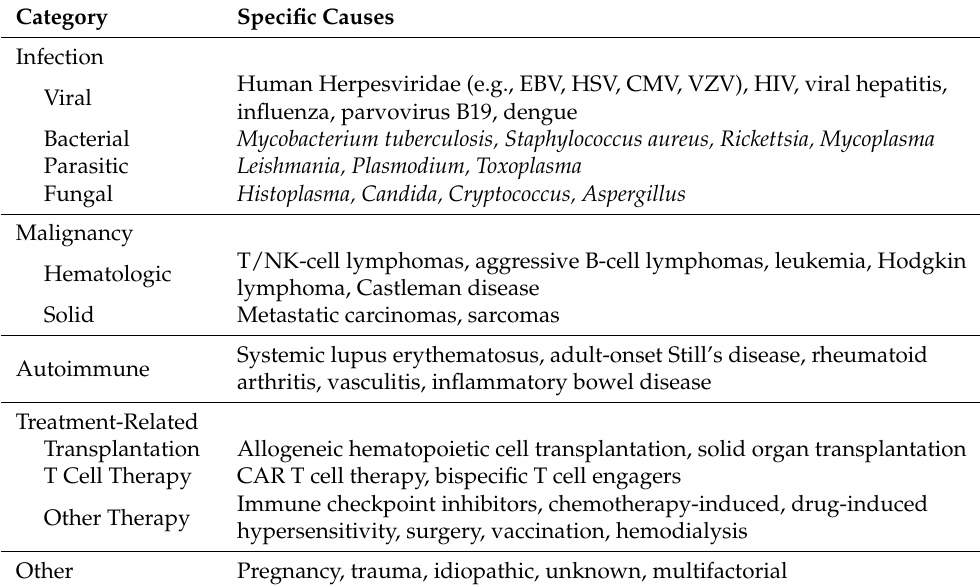
Table 1. Representative Etiologies of Adult sHLH [17].